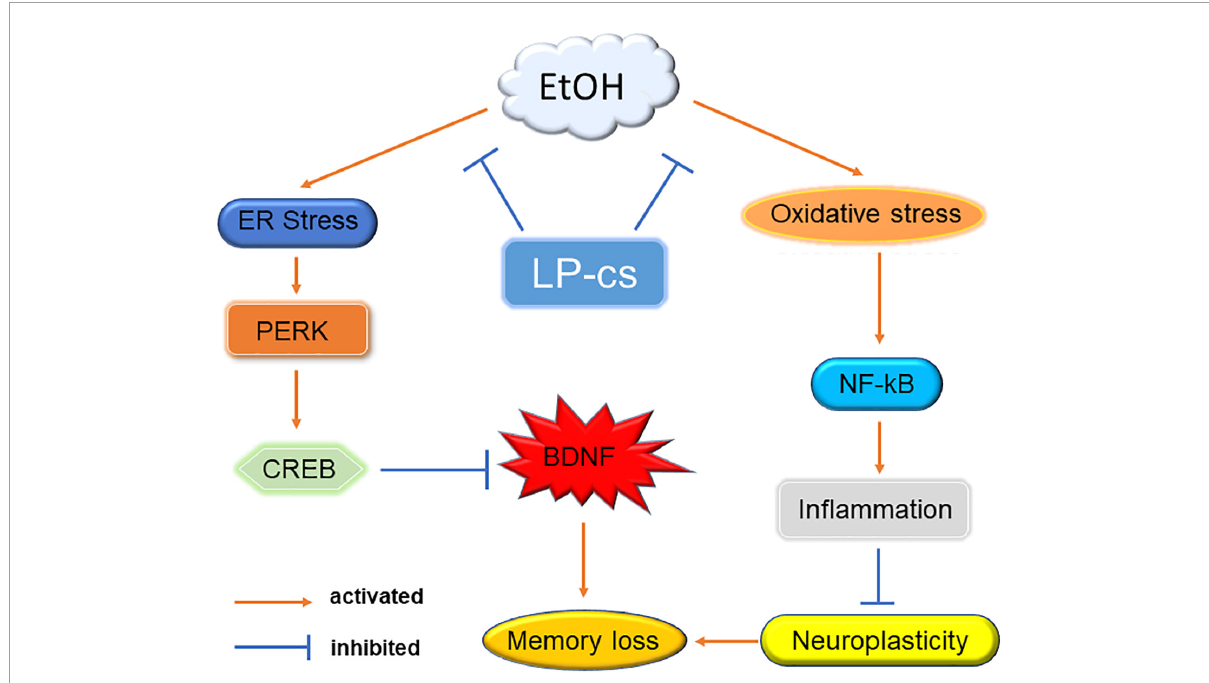
FIGURE8 Mechanism. Alcohol-induced ER stress activates PERK signaling to regulate CREB expression, suppressing BDNF levels. Alcohol induces oxidative stress to activate NF- κ B expression and trigger an inflammatory response, affecting synaptic plasticity. Alcohol eventually leads to memory impairment through these two pathways. LP-cs alleviates alcohol-induced cellular stress.